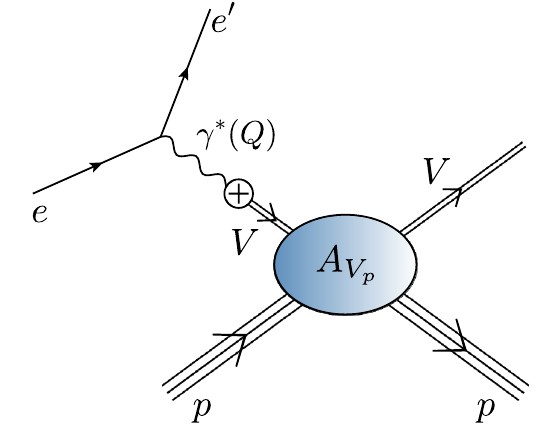
Fig. 1 Electromagnetic production of a vector-meson from the proton: e + p → e (cid:3) + V + p , interpreted as providing access to V + p → V + p using a vector meson dominance model. The VMD transi- tion γ ( ∗ ) ( Q ) → V is indicated by the crossed-circle and is typically assumed to occur with a momentum-independent strength γ γ V